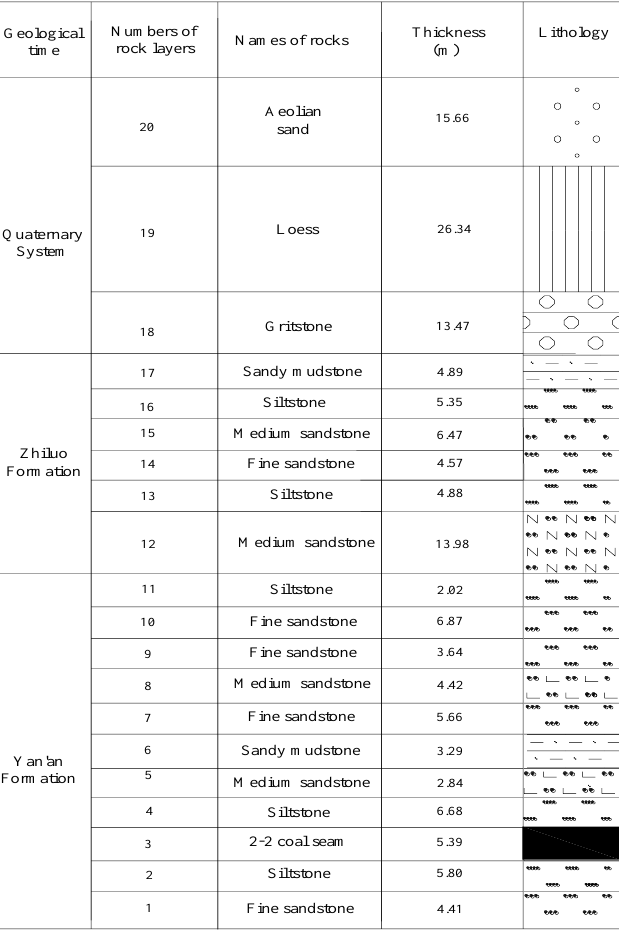
Figure 7. The borehole log of working face 2407. After the surface monitoring points are arranged, the leveling method is used to measure the elevation of all monitoring points (Figure 8a). The surface subsidence value can be calculated by the following formula.